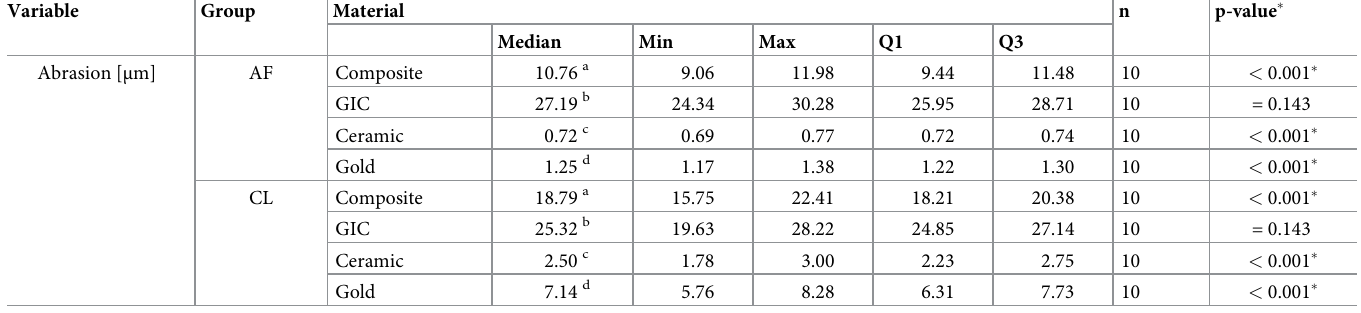
Table 3. Median, maximum, minimum, first and third percentile of abrasion of the different materials in micrometres and mean loss of material after treatment with AF and CL. Variable